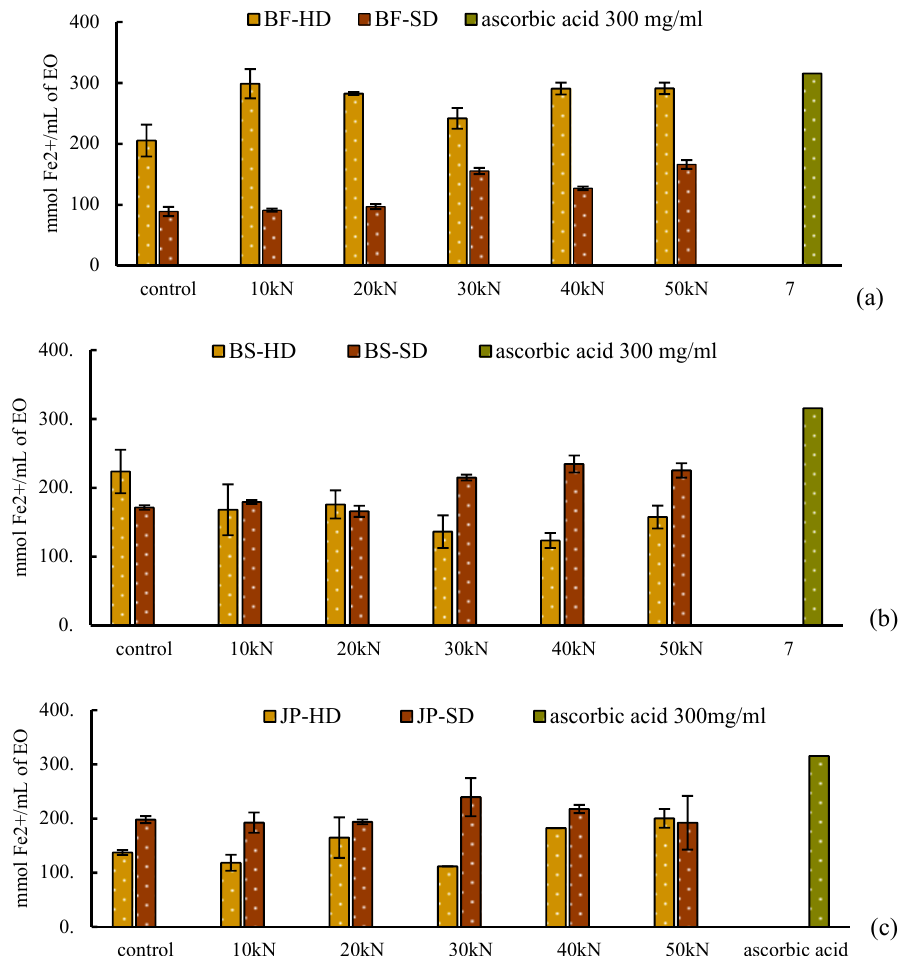
Figure 6. Evaluation of the iron reduction capacity of EOs extracted by hydrodistillation and steam distillation of ( a ) BF, ( b ) BS, and ( c ) JP in bundles at different compaction levels.